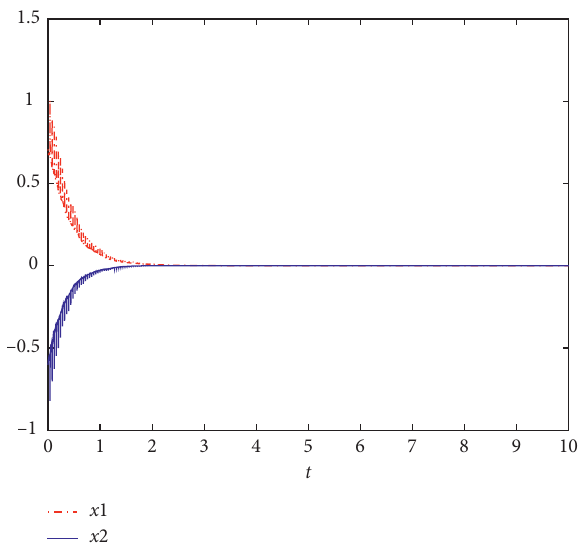
Figure 1: The solution of τ � 1, τ